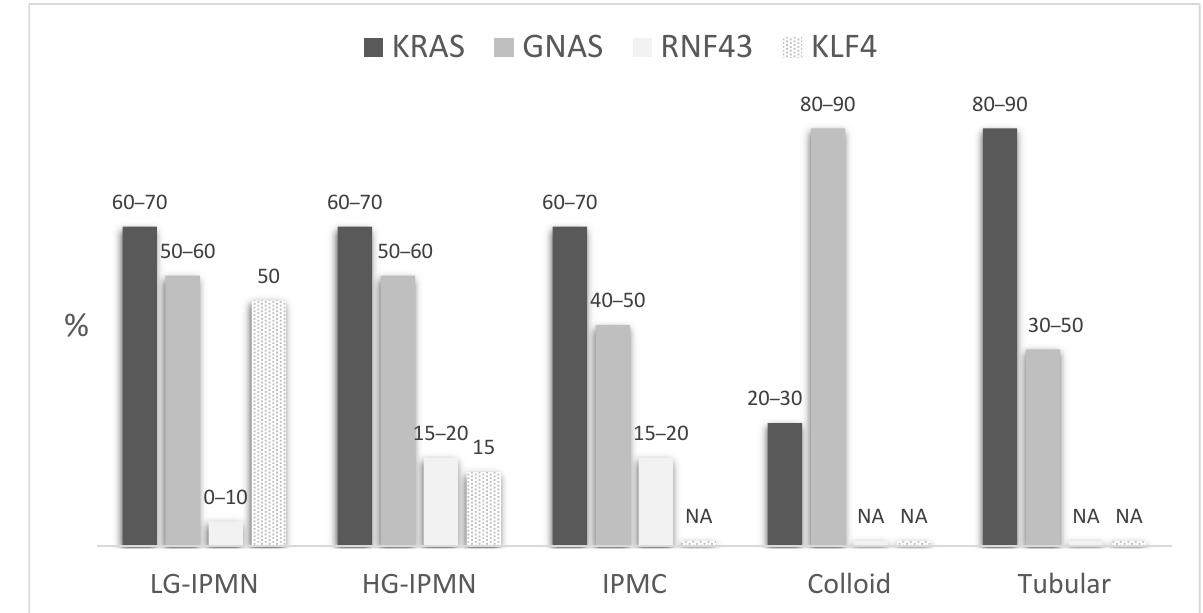
Figure 3. Estimated prevalence of the main genomic alterations in IPMNs and IPMCs, according to the grade of dysplasia and carcinoma subtypes. LG: Low-grade dysplasia; HG: high-grade dysplasia; NA: not available.